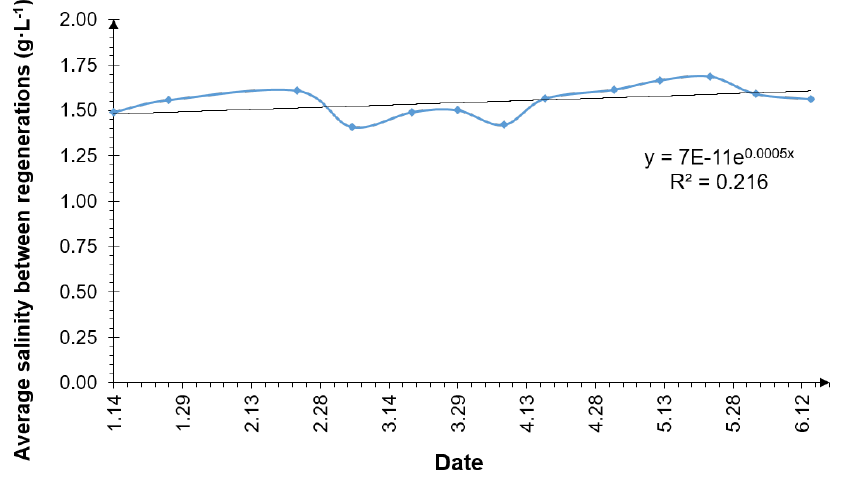
Figure 8. Average NaCl concentration at the septic tank outflow occurring between softener regenerations.